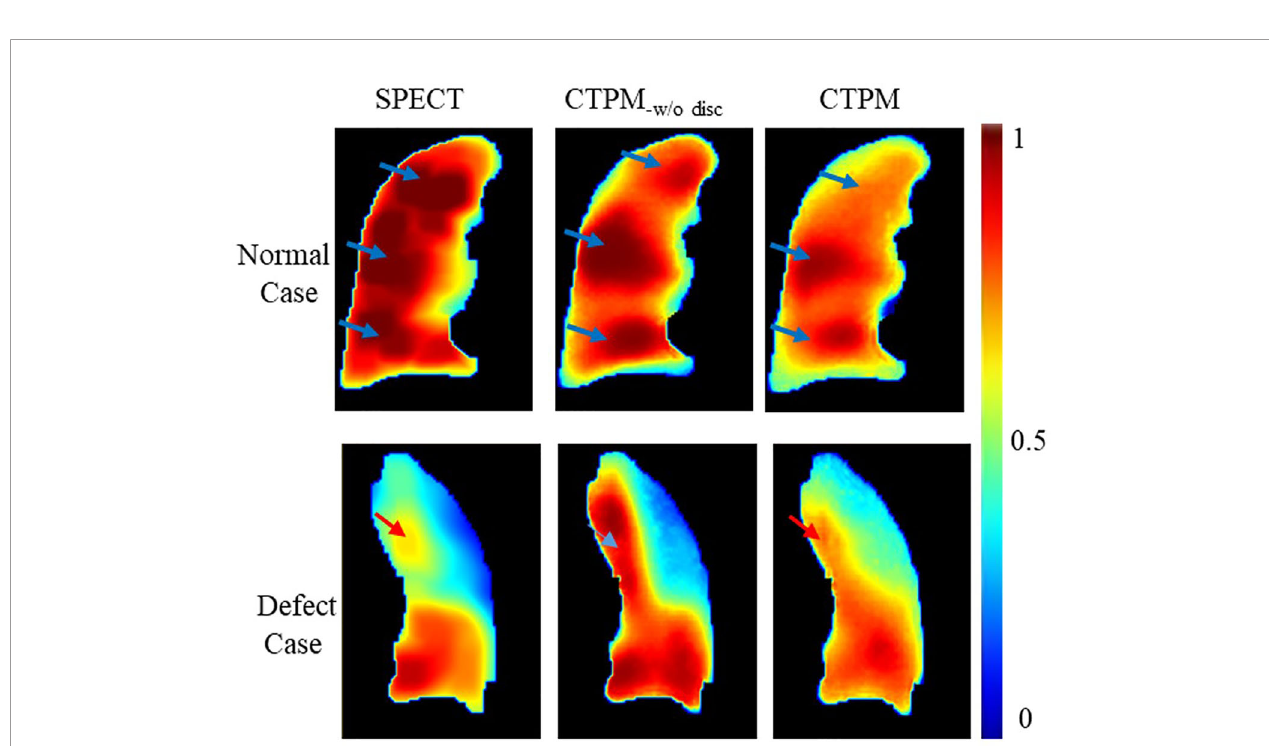
FIGURE 8 | Effects of the SPECT discretization. CTPM -w/o disc indicates prediction without SPECT discretization